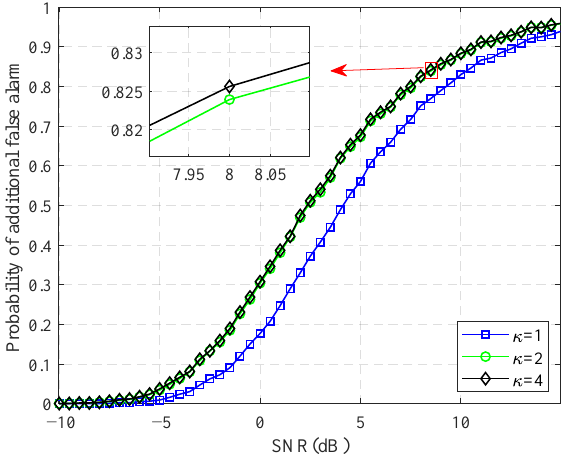
Figure 8. Detection probability of the SRC at (50.93, 1.95) km when P fa = 10 − 5